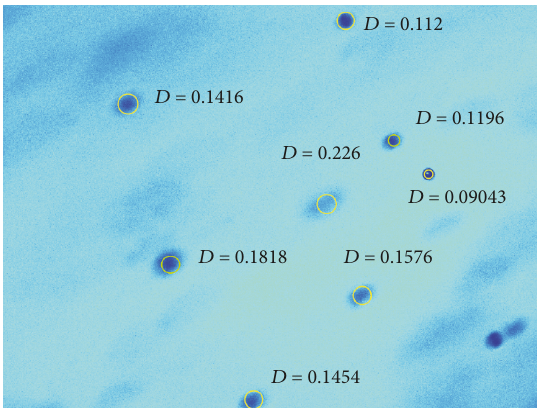
Figure 17: Droplet diameters processed by DaVis software.